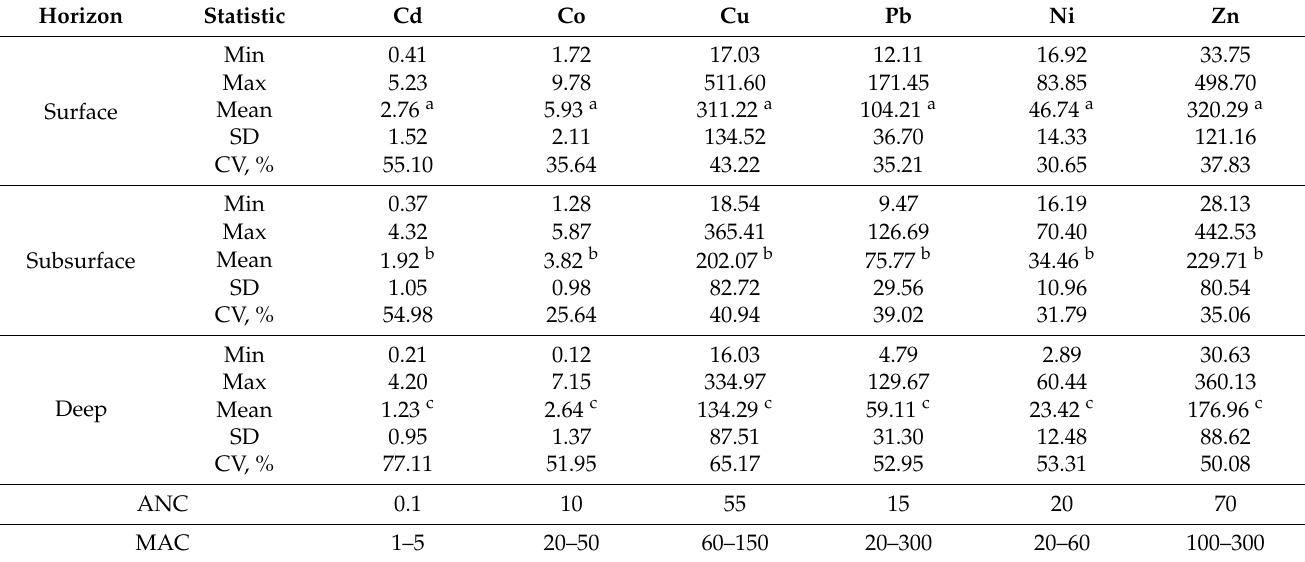
Table 1. Descriptive statistics of metal concentrations (mg kg − 1 ) in the studied